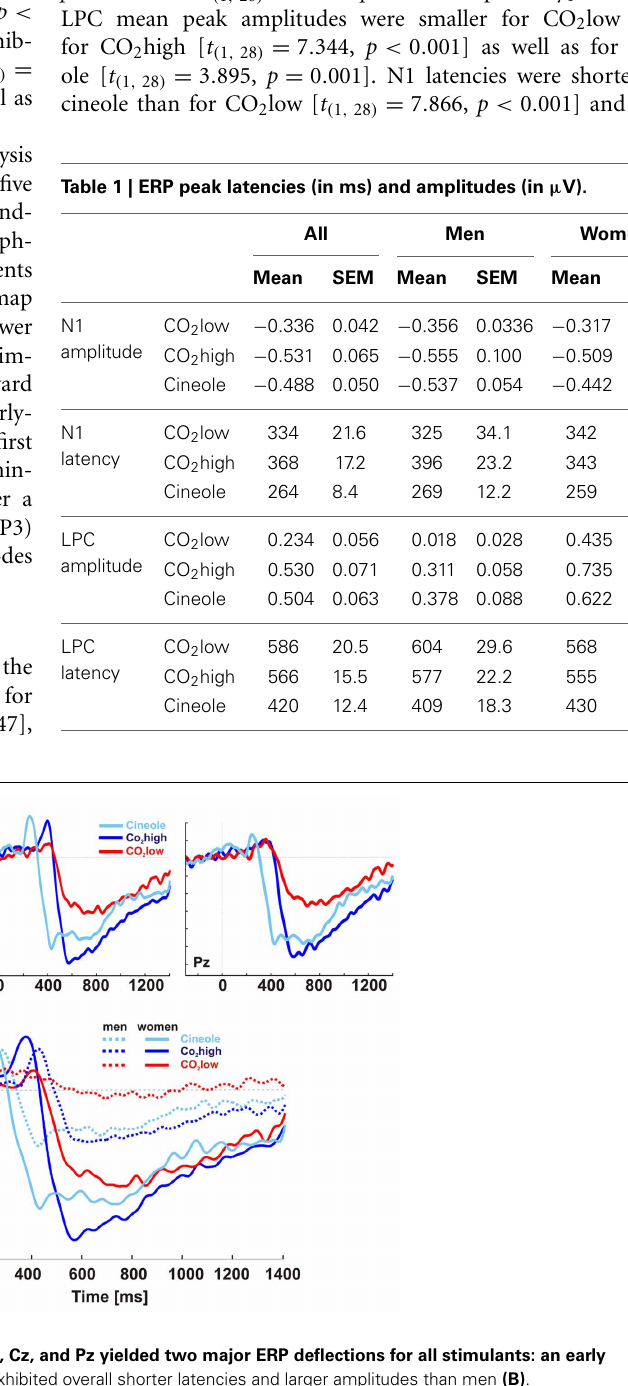
Frontiers in Human